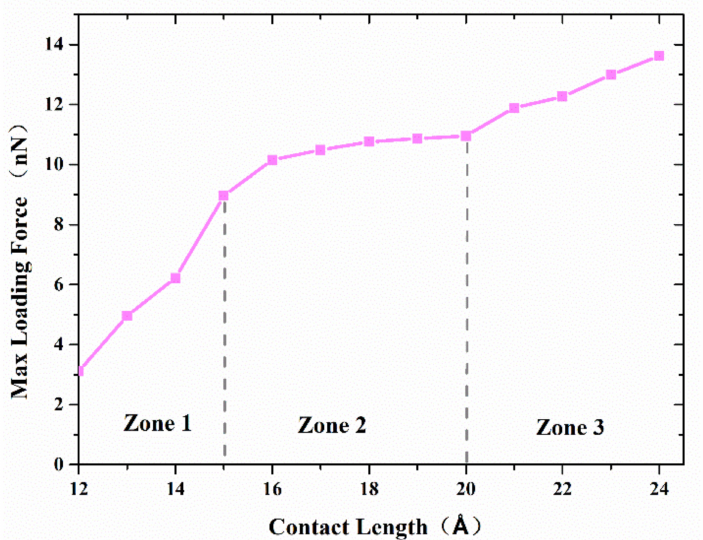
Figure 7. The maximum axial force that the interface can resist with separation distance of 20 Å and various contact length.